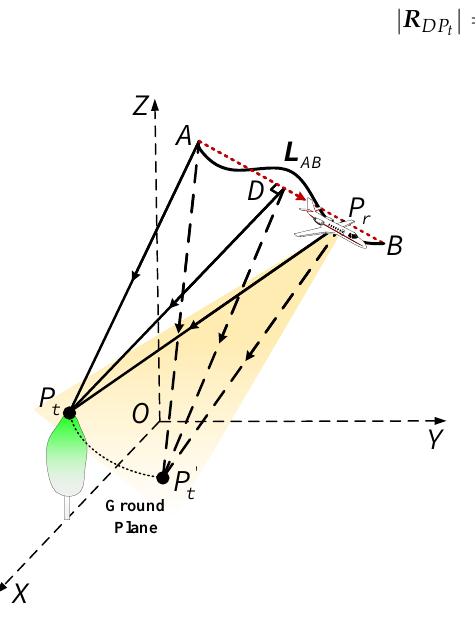
Figure 6. Geometry model of master image